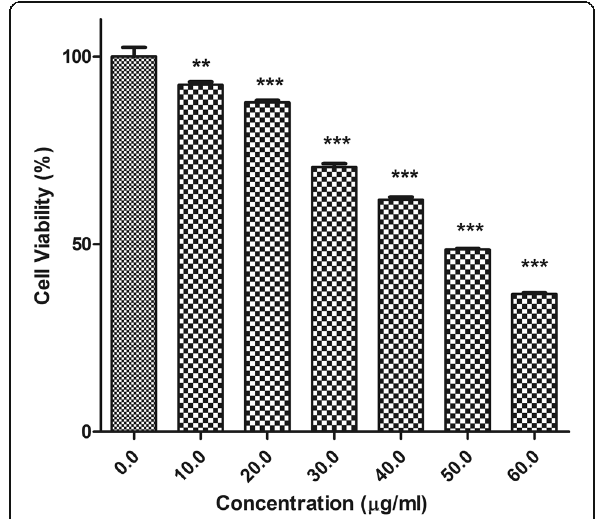
Fig. 8 Cell viability vs concentration on skin cancer cell lines